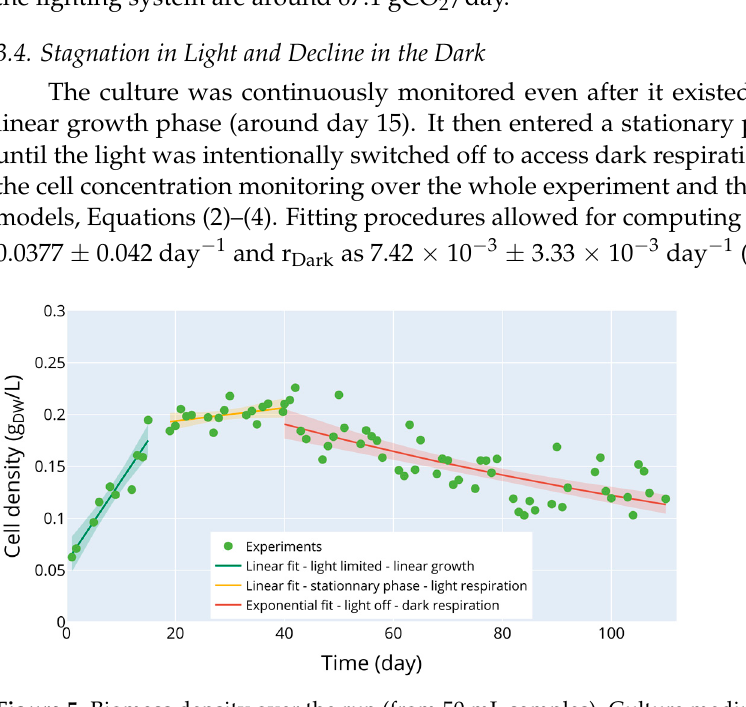
Figure 5. Biomass density over the run (from 50 mL samples). Culture medium volume: 52 L for the first and second phases. Evaporation is accounted for in the calculations for the last phase.